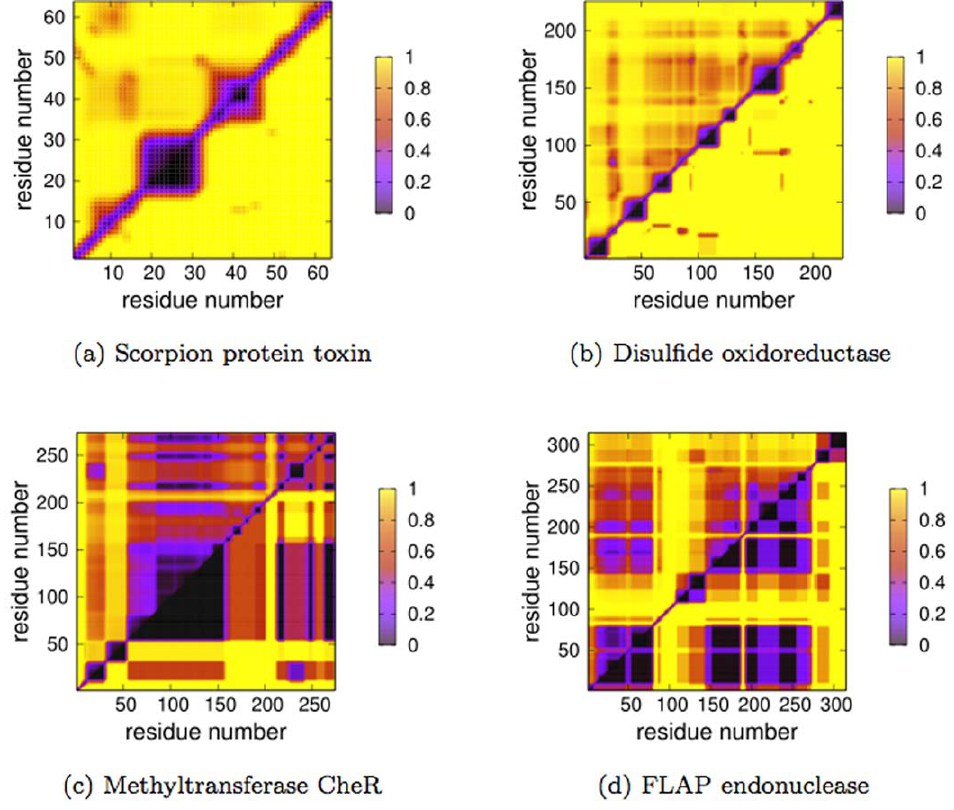
Figure 8. Mechanical Coupling Maps (MCM) provide a more nuanced description of co-rigidity. Specifically, the continuous scale provides a normalized description of how many free pebbles (DOF) are shared between each residue pair (0=0 pebbles, whereas 1=6 pebbles). Again, each MCM is plotted near their respective P RM values for the same four proteins presented Figs. 3a and 7. doi:10.1371/journal.pone.0029176.g008 PLoS ONE |